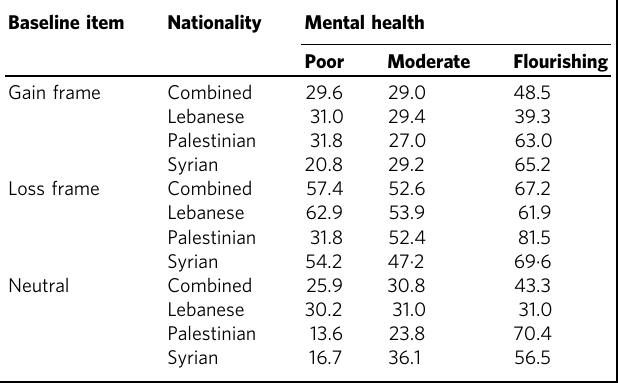
Table 3 Percentage of participants choosing the risky option at baseline by nationality and mental health.